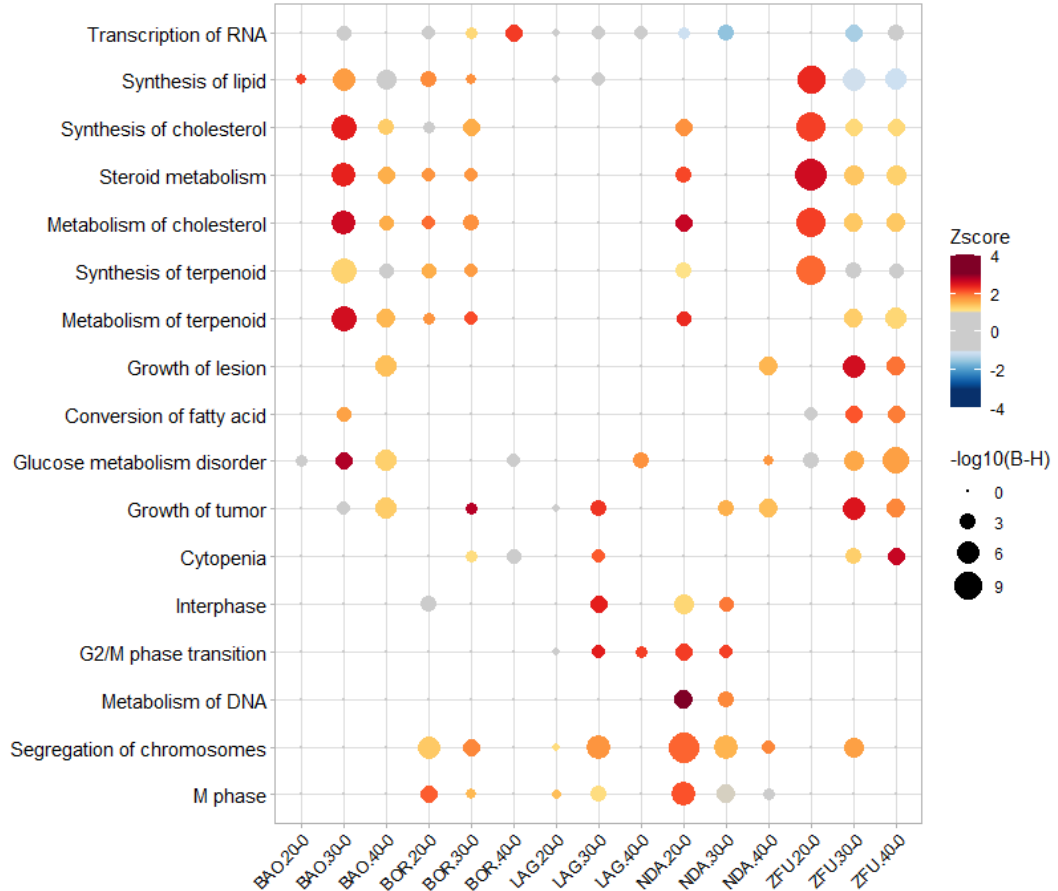
Figure 6 - Plot of 17 significantly enriched diseases and functions inferred as activated in function of the within-breed contrasts. The 15 within-breeds contrasts are shown on the abscissa and the significantly enriched diseases and functions on the ordinate. The size of the circles is inversely proportional to the B-H corrected p -value of the diseases and functions in the aforementioned contrast. The color gradient of the circle corresponds to the Z-score range, i.e. warm color gradient for positive Z-score>1, cold color gradient for negative Z-score<-1, and gray color gradient for Z-scores ranging between -1 and